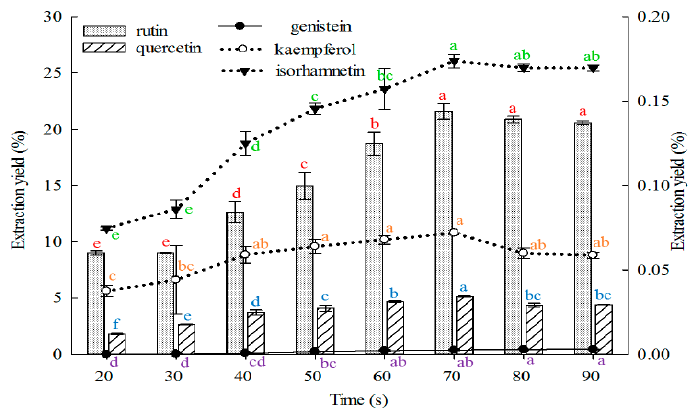
Figure 6. Effect of time on the extraction yields of the five constituents (the bar and lines graphs are referenced to the left and right axes, respectively; different letters stand for significant difference at 5% level).